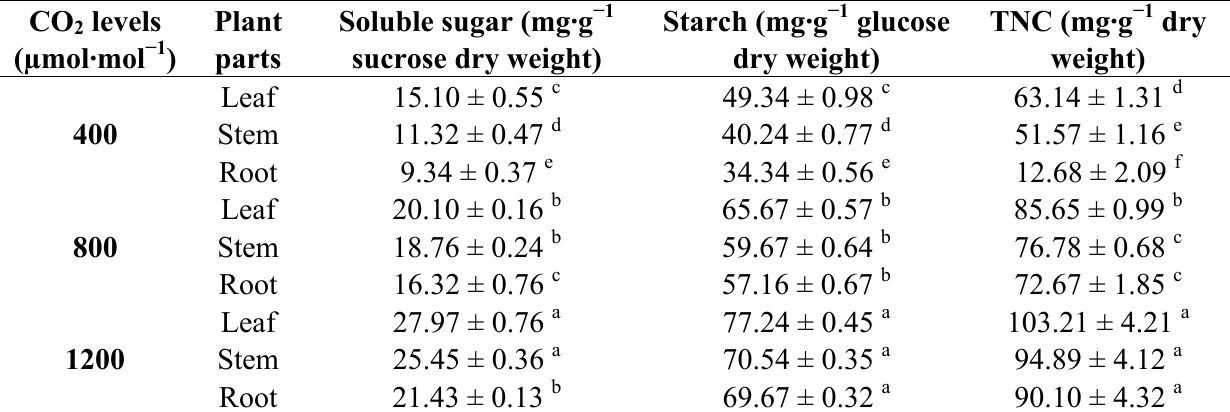
Table 3. Accumulation and partitioning of soluble sugar, starch and total non structural carbohydrate (TNC) in different plant parts of Elaeis guineensis seedlings under different CO 2